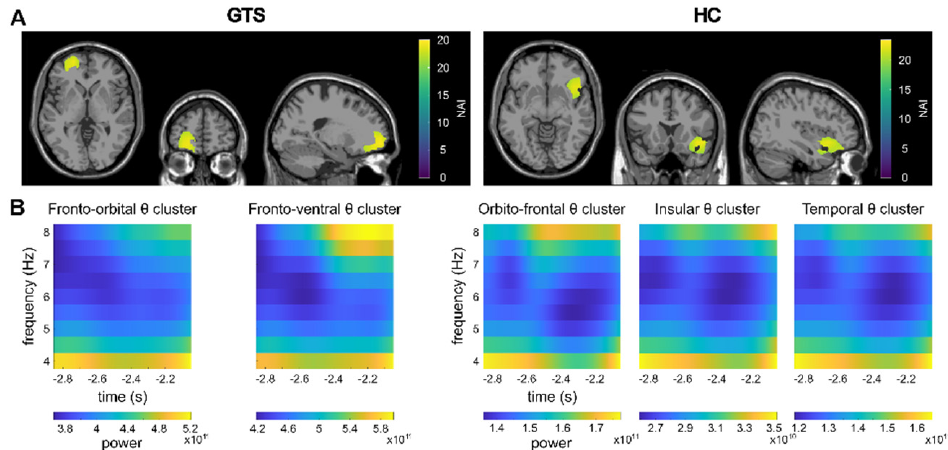
Figure 3. Pre-trial results. ( A ) Clusters as identified by the DBSCAN algorithm in the pre-trial period are shown. The identified clusters (refer to 3. Results ) are visualized on a template MRI. Please note that the clusters are adjacent to each other and therefore cannot be distinguished in this visualization. The Neural Activity Index (NAI) is given for voxels within the clusters with warmer colors representing higher values. ( B ) Time-frequency representations of the theta band in the identified clusters are shown.